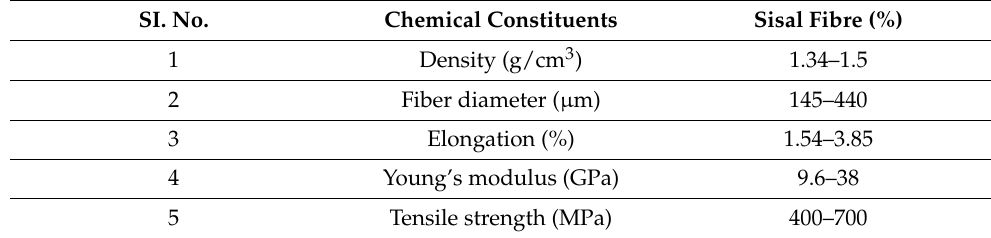
Table 1. Mechanical and physical properties of sisal fibre [25,33]. SI.